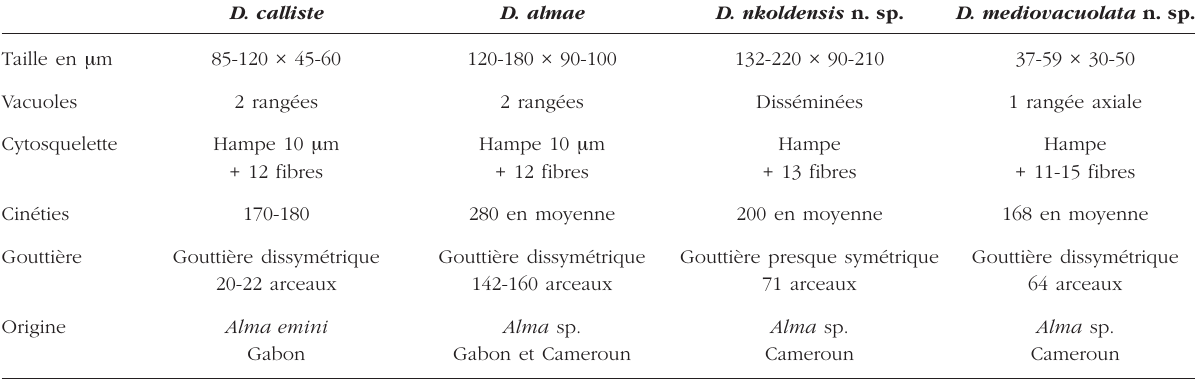
Tableau II. – Comparaison des ciliés du genre Dicoelophrya